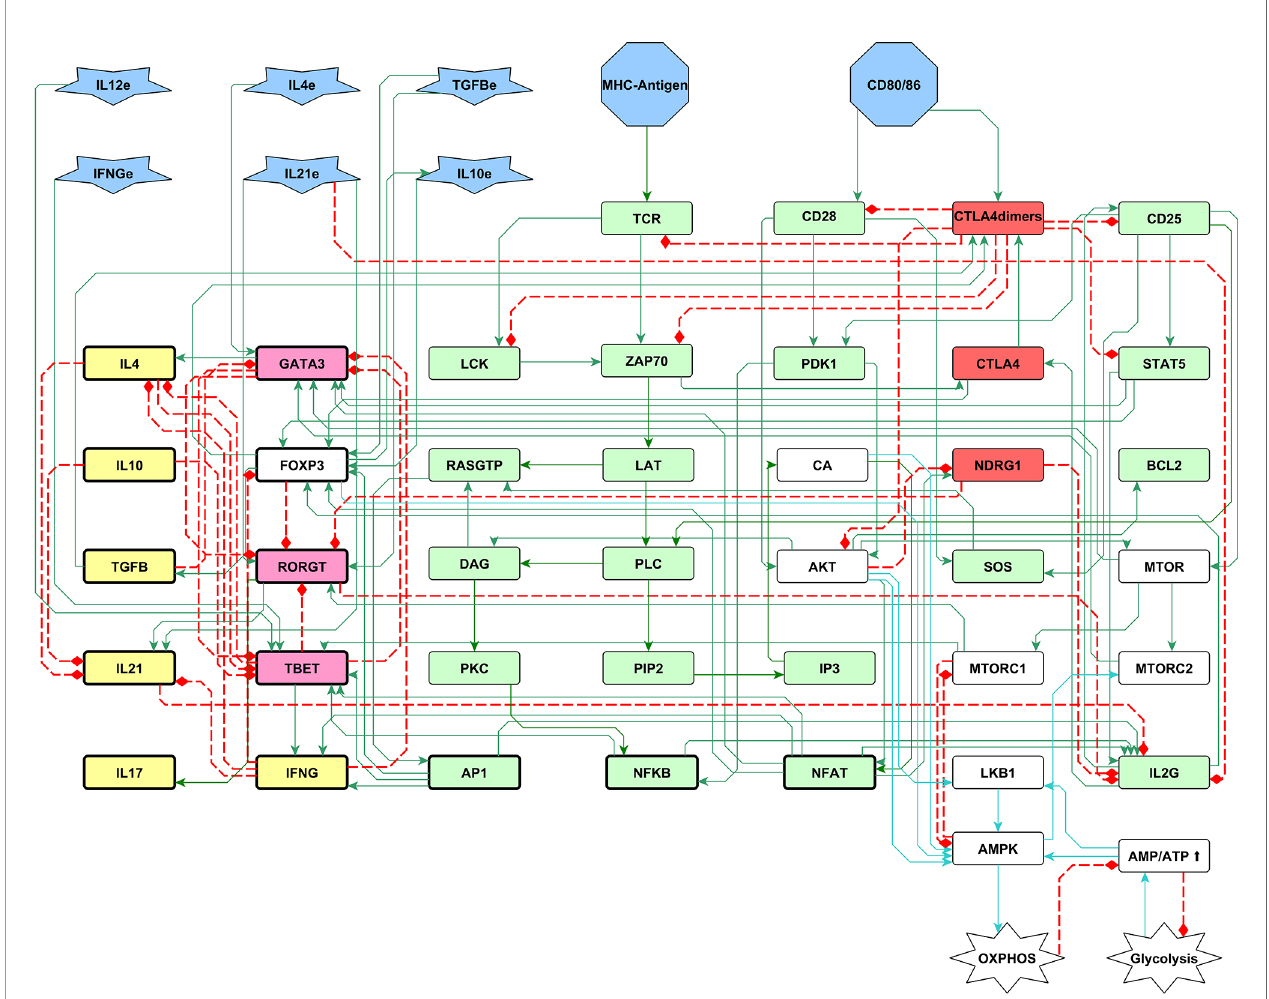
FIGURE 3 | A 51-node network of the early biochemical interactions induced by TCR activation, co-stimulation, and phenotype-inducing cytokines. Inputs of the network are the MHC-antigen, the co-stimulatory molecules CD80/86, and external cytokines (blue polygons). The set of interacting rules de fi ning the dynamical system for Boolean modeling is shown in Supplementary Material 1 . Boolean rules were translated to continuous functions as shown in Material and Methods, and the complete set of ordinary differential equations is provided in Supplementary Material 2 . Green and red rectangles represent stimulatory and inhibitory nodes of the activation core, respectively. Pink and yellow rectangles represent phenotype-inducing transcription factors and cytokines produced endogenously, respectively. White rectangles represent the metabolism module including AMPK as a central regulatory element, as shown in fi gure 2. Construction of the network can be consulted in (40). LAT: LAT-Gads-SLP-76 complex; IL2G: IL-2 gene; L4e, IFN g e, IL10e, TGF b e and IL21e: exogenous